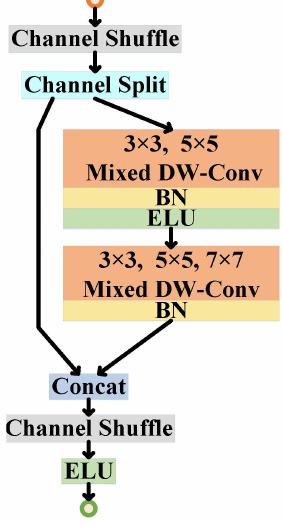
Figure 4. Our Efficient Residual Module Design. Table 1. Detail of each layer, here, DW: Depthwise and MDW: Mixed-Depthwise. All different convolutions in MDW are